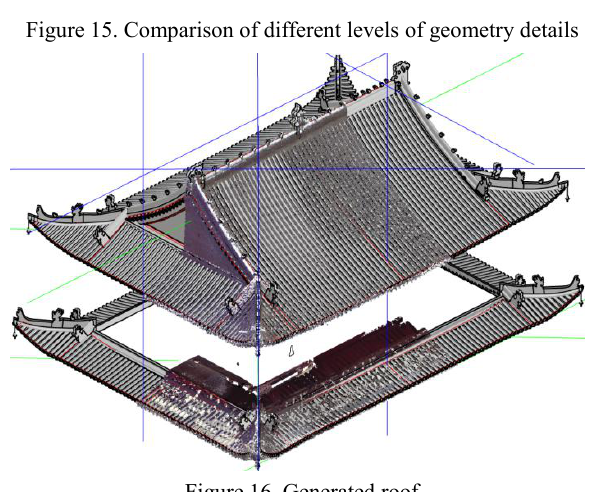
Figure 16. Generated roof